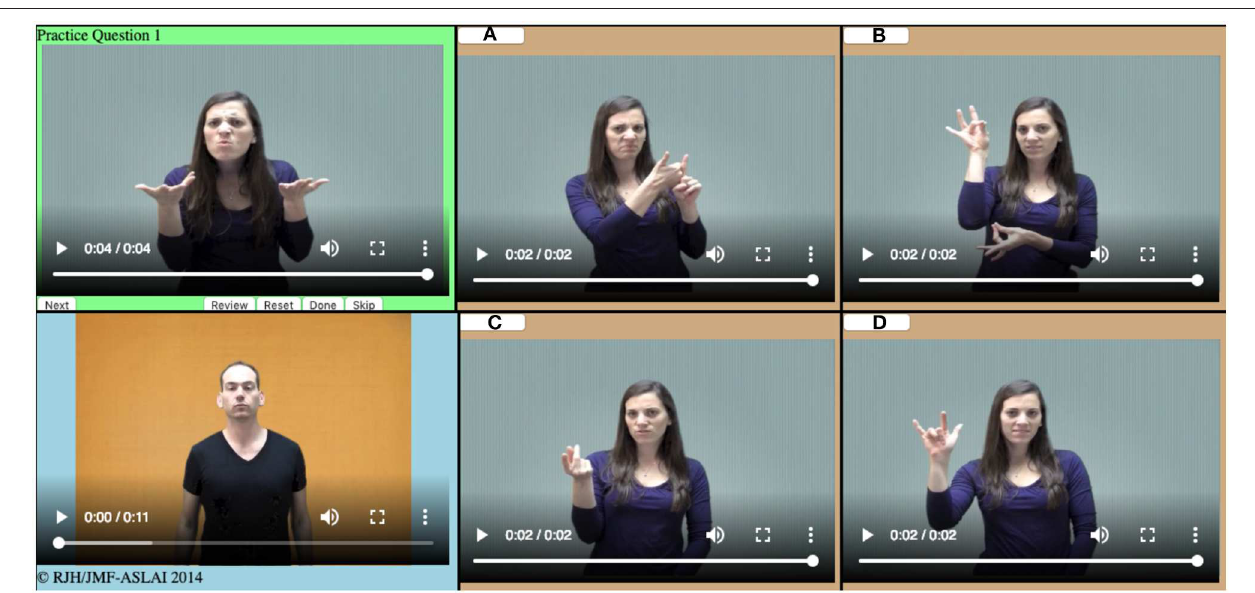
FIGURE 1 | Sample screenshot of one test question. The top left panel is the comprehension question, with a still image of the sign WHAT. The bottom left panel shows the ASL text, which participants will have already reviewed, but is available for review as students make their answer. The four panels on the right are each of the answer choices, with a button labeled with a letter that corresponds to their answer choice. (A) SELF; (B) GHOST; (C) DOG; (D) AIRPLANE. Written informed consent was obtained from the individuals in this image.